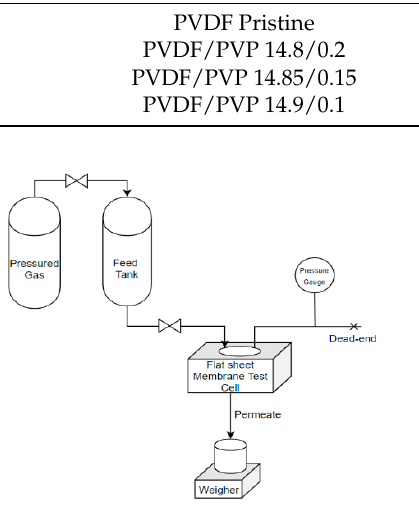
Figure 1. Illustration of the ultrafiltration process. Table 2. Water contact angle of PVDF with various additions of PVP.